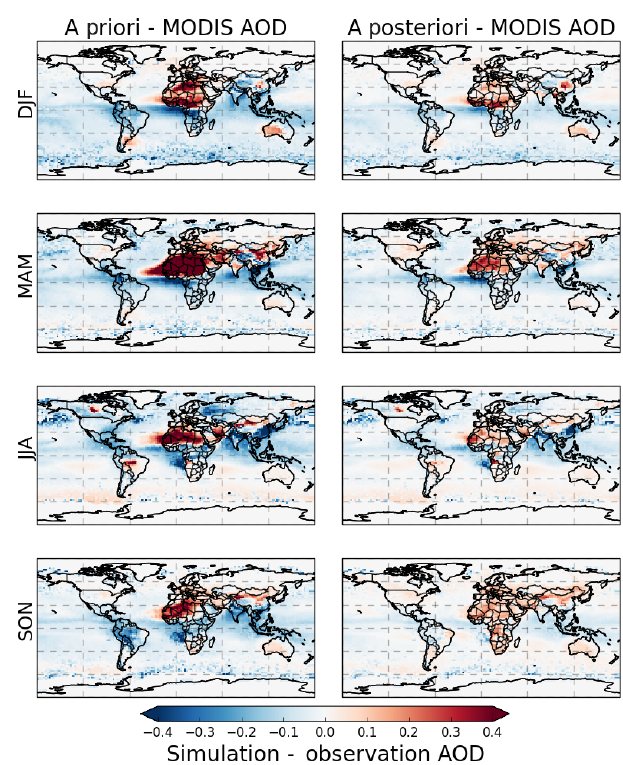
Figure 10. Differences between a priori and a posteriori GEOS- Chem seasonal AOD with MODIS C6 merged